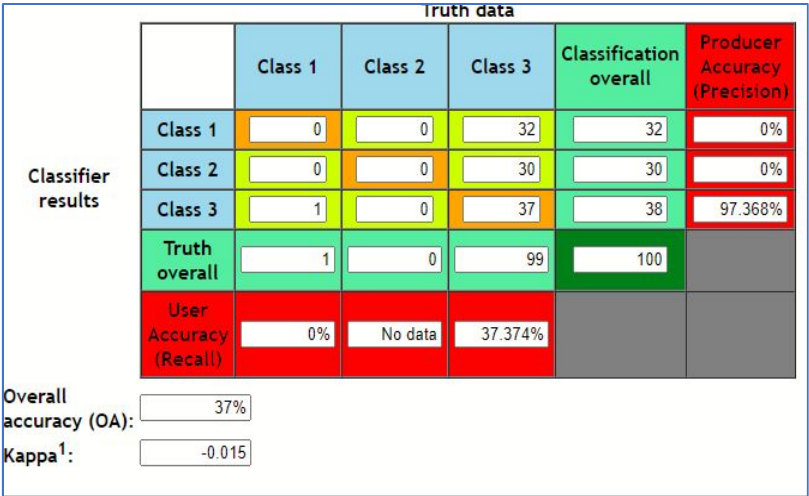
Figure 7. SVM Sigmoid Confusion Matrix. The accuracy of SVM (Sigmoid Karnal) is 37% as shown in the truth table (Figure 7).